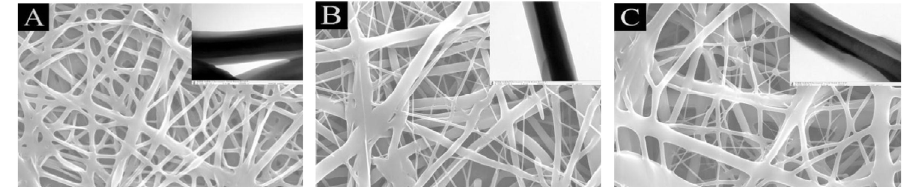
Figure 5. SEM images of the PCL/PVA core ‐ shell nanofibers with flow ratios of: ( A ) 0.5:0.5; ( B ) 0.5:0.6; ( C ) 0.5:0.7; insets of the SEM images were the corresponding TEM images of the fibers. Reprinted/adapted with permission from Ref. [62]. 2021, Elsevier.